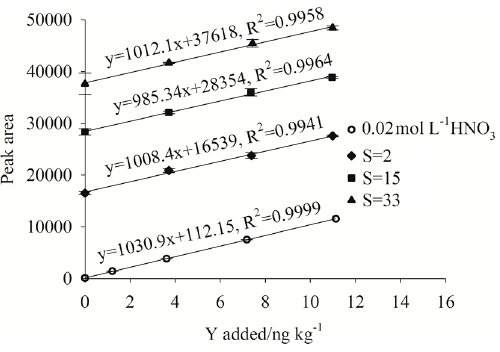
Figure 4. Standard additions calibration curves for Y based on samples having different matrices.